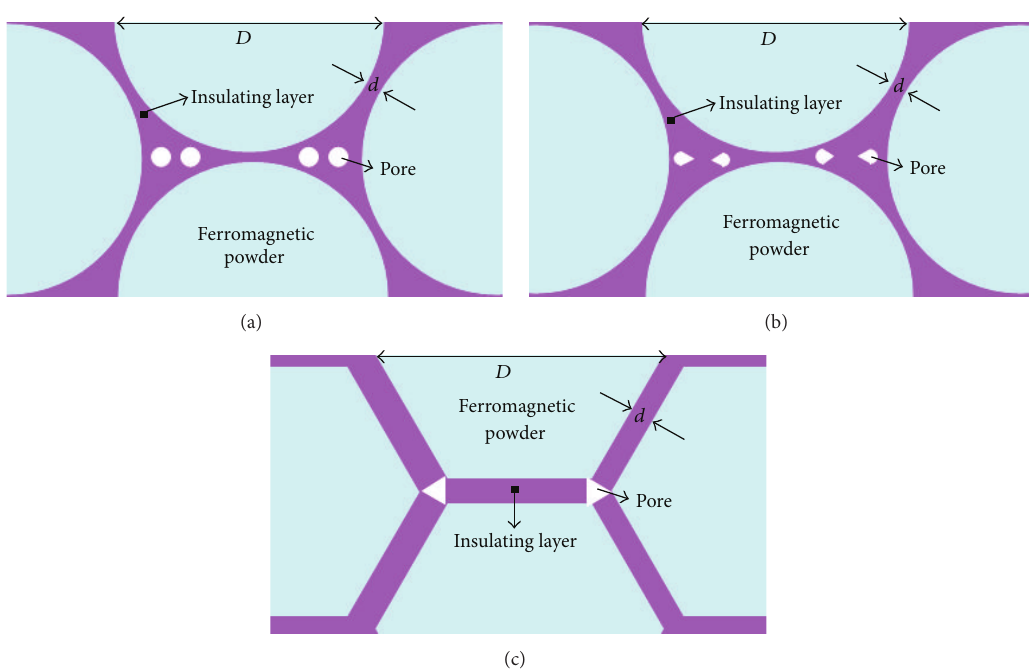
Figure 11: Simplified models: (a) circular pores; (b) circular pores with acute angle; (c) hexagon pores with acute